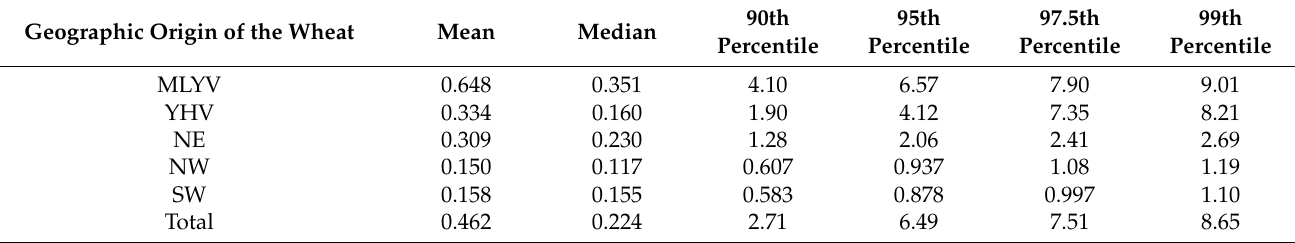
Table 4. The estimated dietary DON exposure through wheat-based products from different areas for 7- to 10-year-old girls determined by point evaluation ( µ g/kg bw/day).